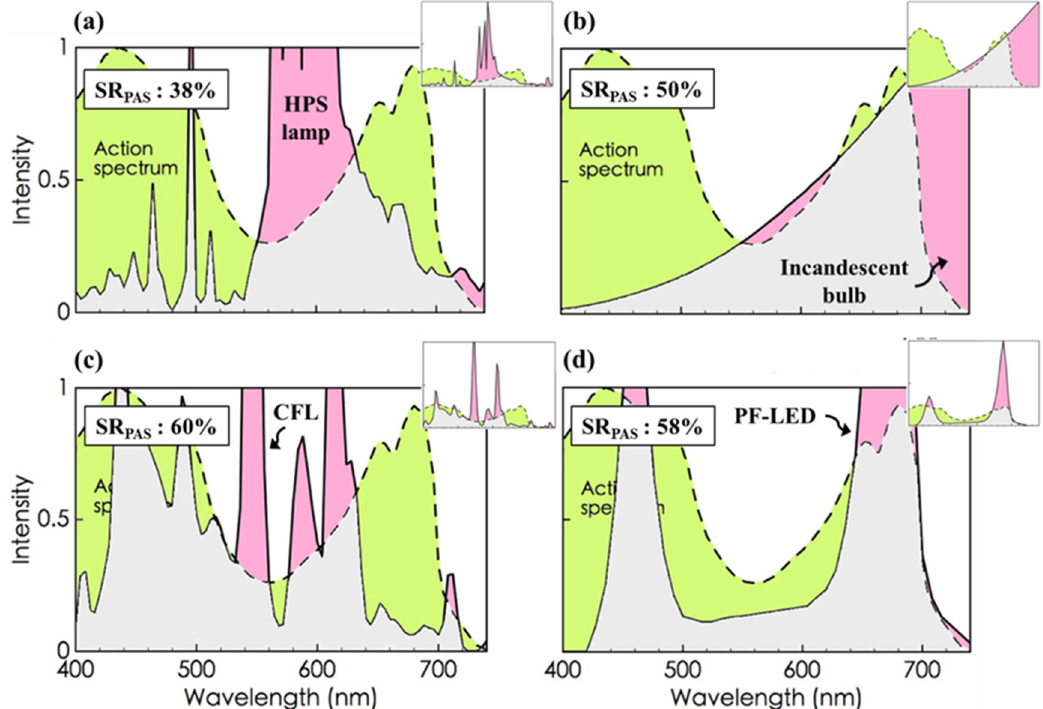
Figure 2. Spectrum resemblance with respect to the photosynthetic action spectrum (PAS), SR PAS , for the current lighting devices, including ( a ) a high pressure sodium (HPS) lamp; ( b ) an incandescent bulb; ( c ) a compact fluorescent lamp (CFL); and ( d ) a plant factory light-emitting diode (PF-LED). The SR PAS can also be evidenced by the overlapping area shown in grey, where the area under the dash curve (in green) is for the action spectrum and that under the solid curve (in pink) is for the compared light source. Insets show the entire emissive spectra of the current light sources. The action spectrum data was adopted from Concepts in Photobiology: Photosynthesis and Photomorphogenesis [9]. The PF-LED data was adopted from the LumiGrow ES330 LED Grow Light Spectrum.